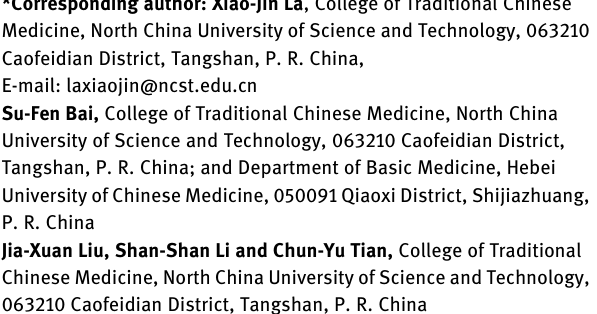
Table 2 contains the list of the atoms including atomic coordinates and displacement parameters.